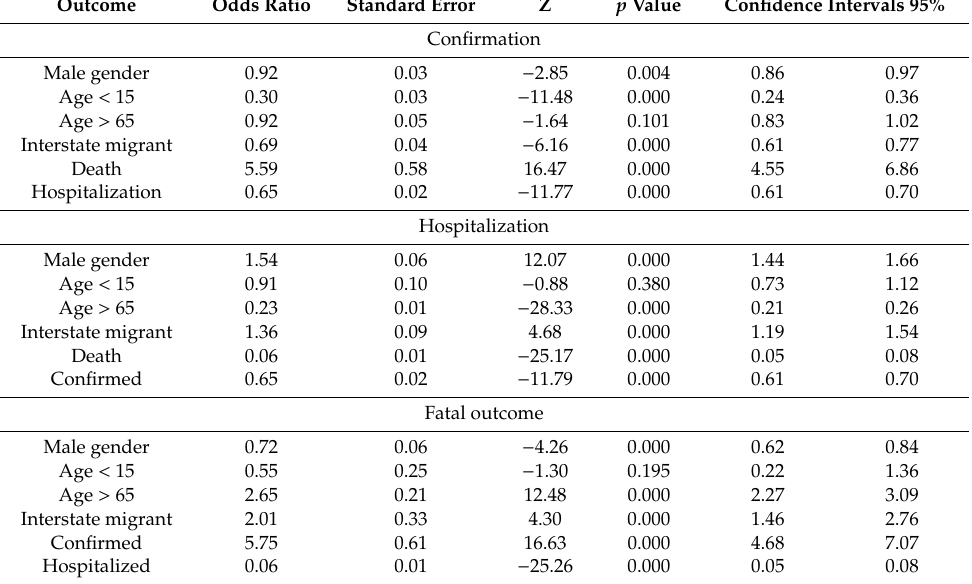
Table 4. Sociodemographic characteristics associated to COVID-19 confirmation, hospitalizations, and death in Mexico between 28 February and 21 April ( n = 17,763 cases). Outcome Odds Ratio Standard Error Z p Value Confidence Intervals 95%